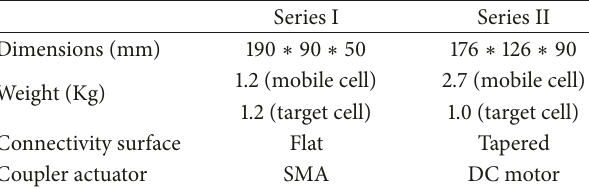
Figure 5: ATRON MSRR (http://modular.tek.sdu.dk/index.php? page=robots). Table 1: CEBOT, cell physical